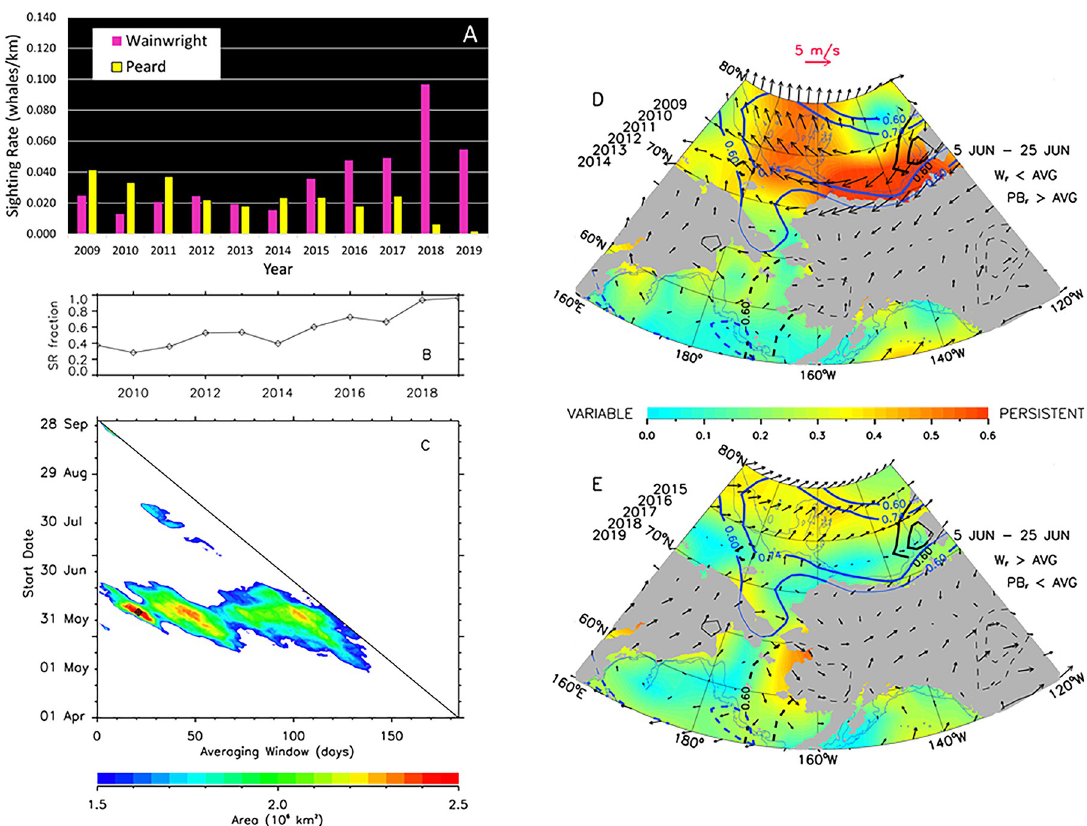
Fig 9. Relationship between gray whale sighting rates (SR) and wind forcing, including: Histogram of combined average July-August- September SR in the Wainwright and Peard Bay analytical areas (A); Wainwright area SR fraction (B); ICA heat map showing the area of the Bering-Chukchi-Beaufort ocean domain over which correlations between the SR fraction and time-averaged winds are statistically- significant (r > 0.602, p < 0.05; df = 9, two-tailed test) (C); mean atmospheric circulation from 5 June to 25 June for years in which the Wainwright SR fraction was less than average and the Peard Bay SR fraction was greater than average (D); mean atmospheric circulation from 5 June to 25 June for years in which the Wainwright SR fraction was greater than average and the Peard Bay SR fraction was less than average (E). Mean wind vectors plotted at every 2nd ith grid point. Color shading indicates wind directional constancy, with correlations between SR fraction and U-component winds (blue contours) and V-component winds (black contours) statistically significant at r = 0.60 (p < 0.05) and 0.74 (p <